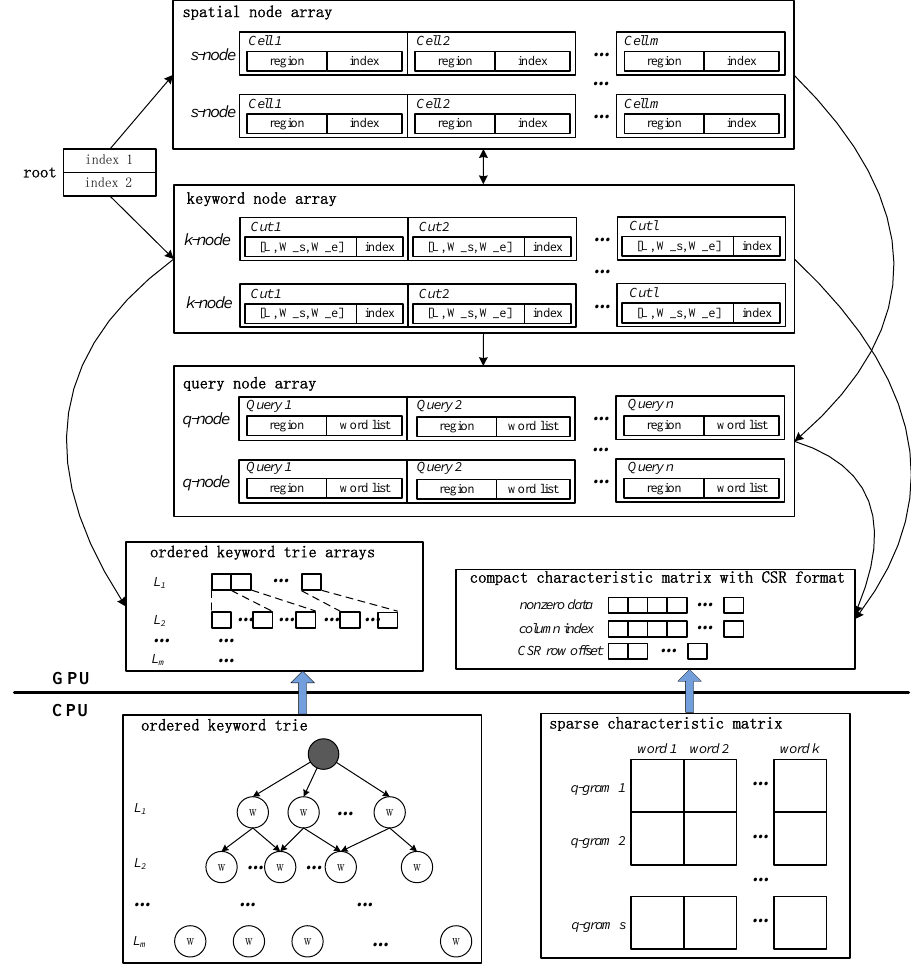
Figure 4. Illustrating the structure of G-AP-tree +